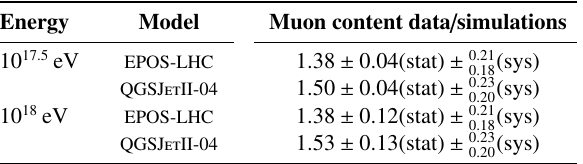
( EPOS-LHC ) and 50 − 53% ( QGSJ et II-04 ) at fixed